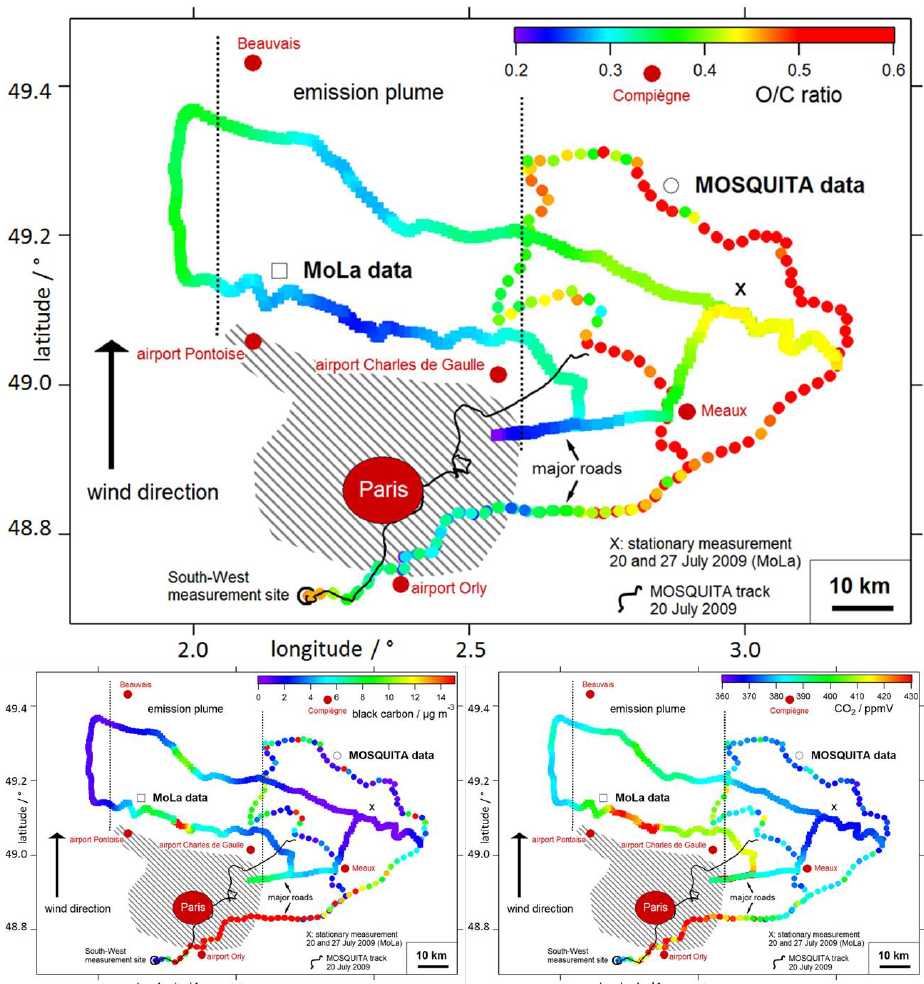
Fig. 4. Combined results of MoLa (line of squares) and MOSQUITA (dotted line) mobile applications of four cross-section measurements through the Paris emission plume during the summer campaign on 29 July 2009. Both data sets have a time resolution of 1min, but were smoothed for this graph (boxcar smoothing algorithm, 10 points). The regional wind direction was constantly from South on this day (black arrow). The track is colour-coded by the O/C ratio (upper large graph), black carbon mass concentration (lower left graph) and CO 2 mixing ratio (lower right graph). The urban area of Paris is marked by the big red dot, the Paris metropolitan area is indicated by the grey shaded area. The cross (“X”) marks the location of the stationary measurements on 20 and 27 July 2009 (see Sects. 3.1 and 3.4). The black thin line shows the track of the MOSQUITA mobile measurement on 20 July 2009 (see Sect.